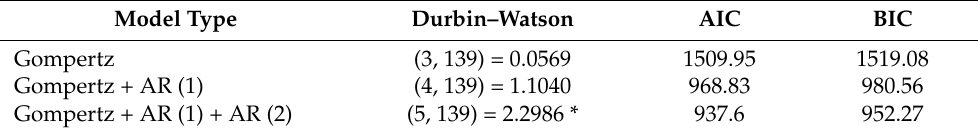
Table 9. Comparison models by goodness of fit criteria for the state of